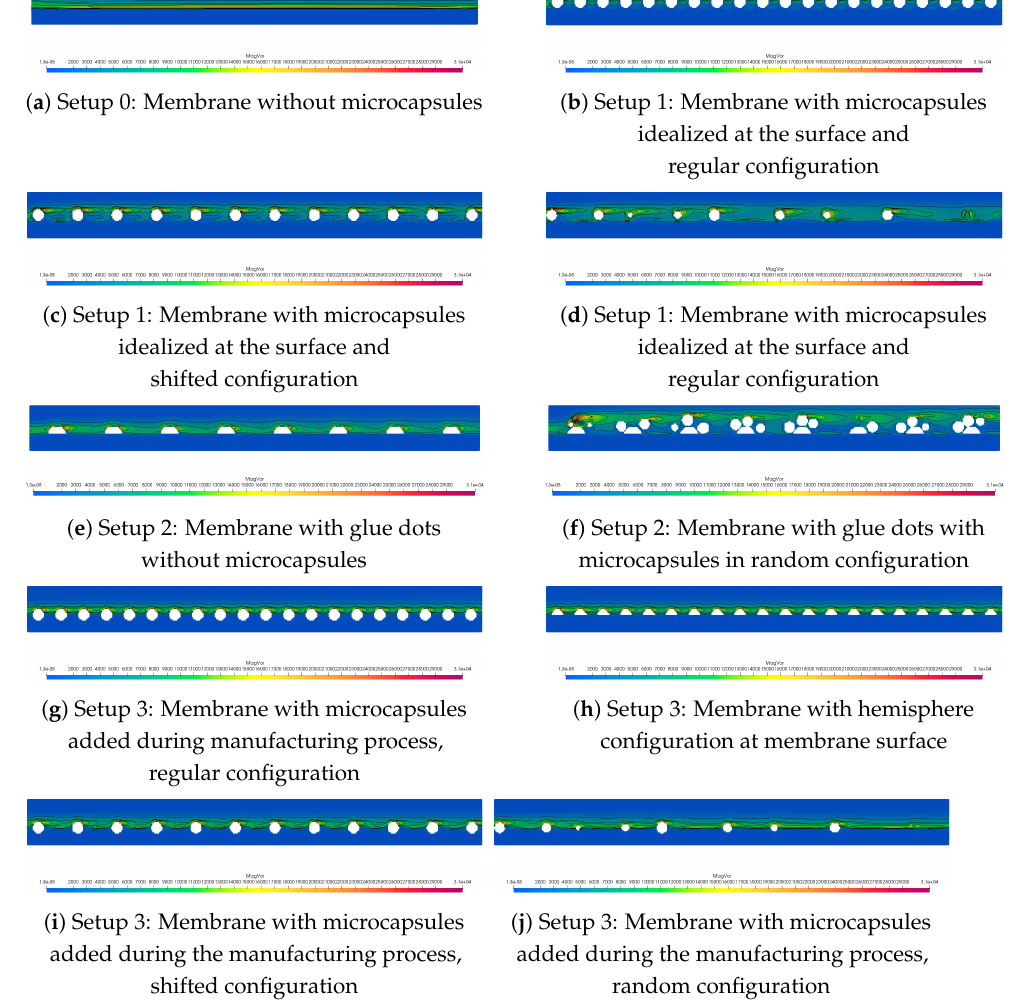
Figure 9. Overview of the vorticity contours for the different setups.